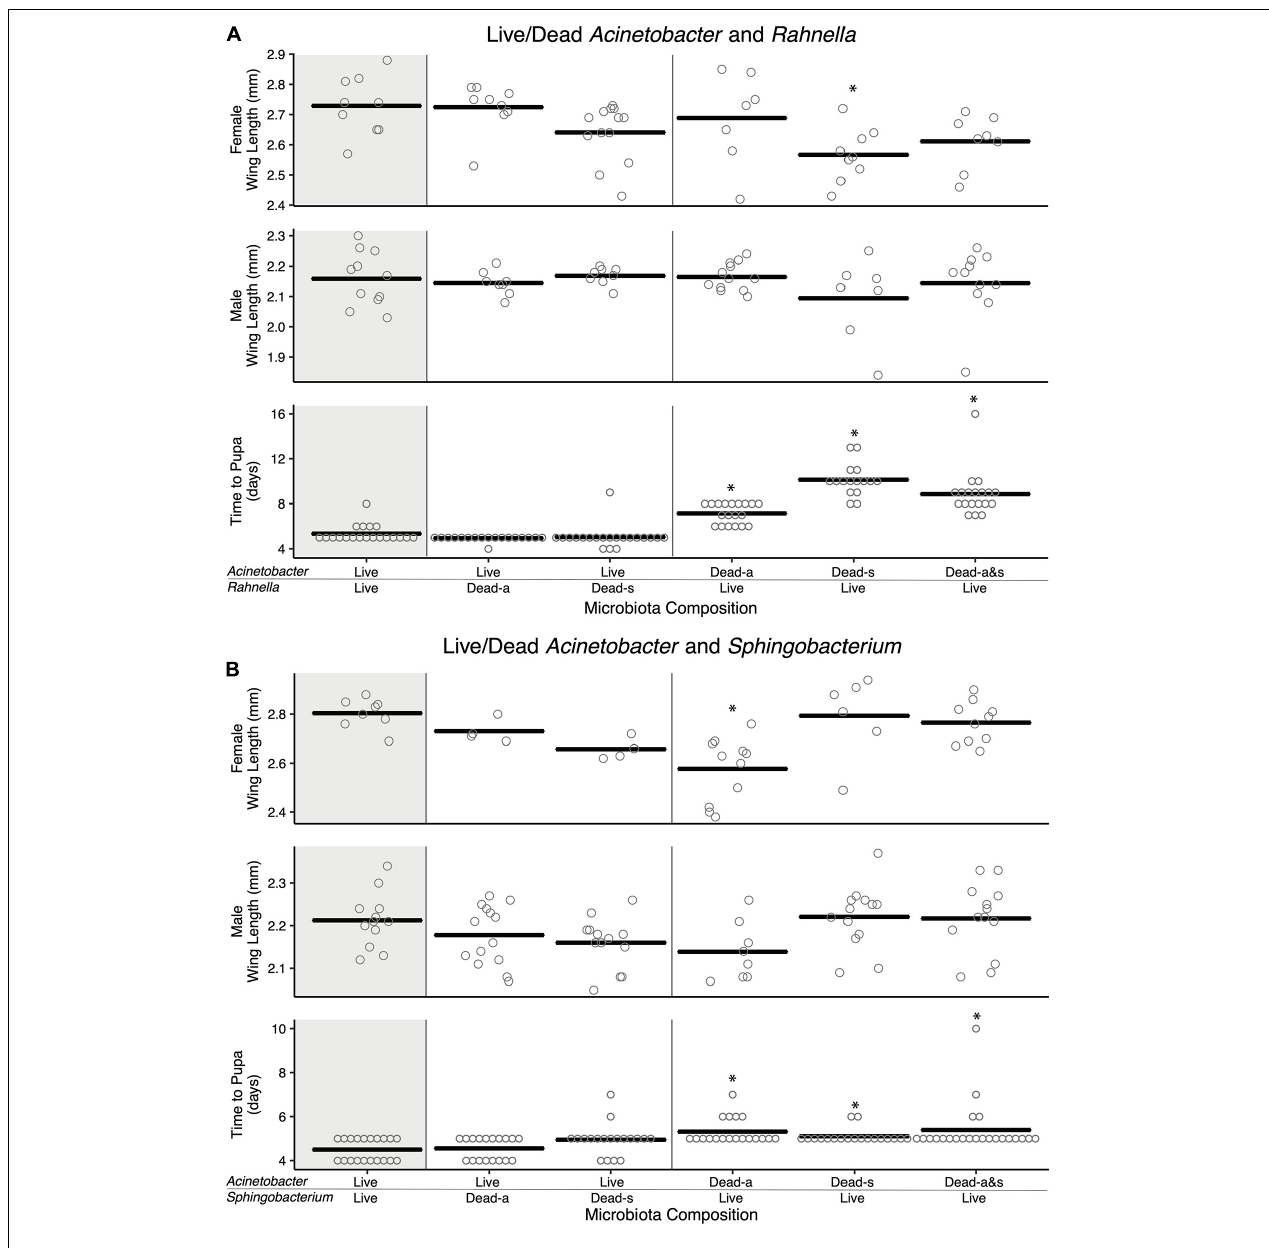
FIGURE 4 | Amendment with dead bacterial cell components shows species-specific and context-dependent ability to restore adult size and development time. Pairwise combinations of living and dead cells were performed for two sets of bacteria: (A) Acinetobacter and Rahnella , and (B) Acinetobacter and Sphingobacterium . Bars indicate mean abundance for the treatment and asterisks indicate a significant difference from control (paired living bacterial microbiota) by Dunnett’s test for wing length and Steel’s test for pupation time. Dead-a (autoclaved) or Dead-s (sonicated and 0.2 µ m filtered) cells were added to living cultures